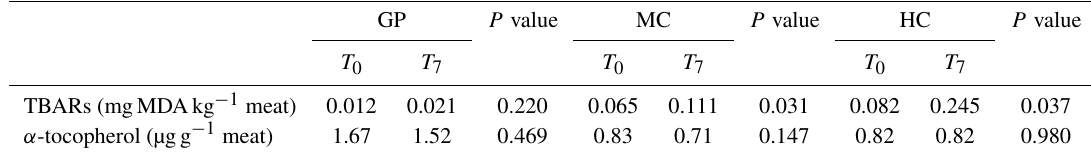
Table 4. Effect of feeding regimes (grass pasture, GP; medium level concentrate, MC, and high concentrate levels, HC) and postmortem time ( T 0 and T 7 represent 0 and 7d, respectively) on lipid stability (expressed as TBARs) and α -tocopherol content in meat from young Retinta bulls.